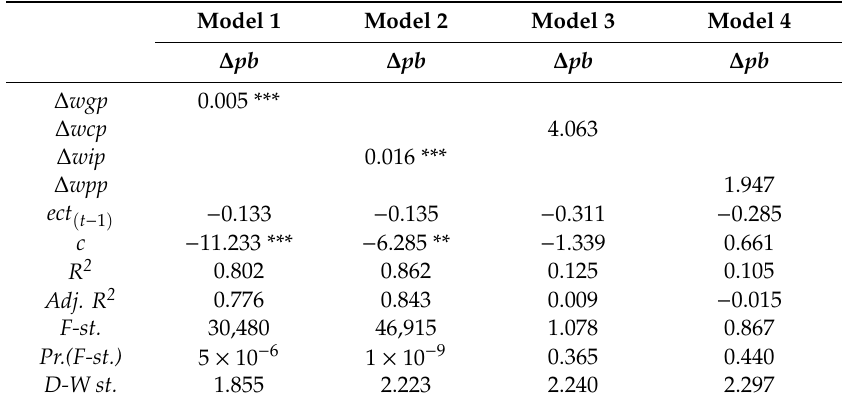
Table 1. The dependency of oil price on the world GDP, industry production, demand and supply for